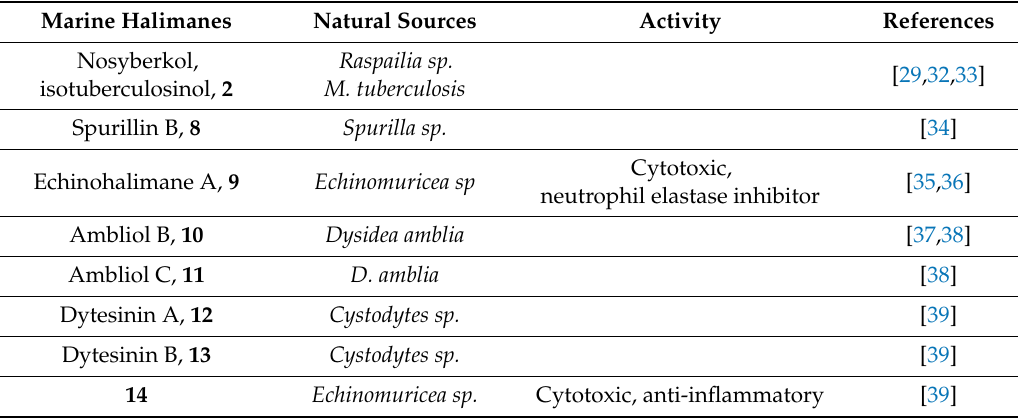
Table 1. Natural sources and activities of marine origin halimanes.